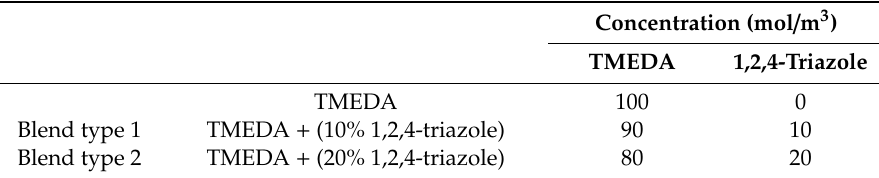
Table 3. Concentration of TMEDA-based